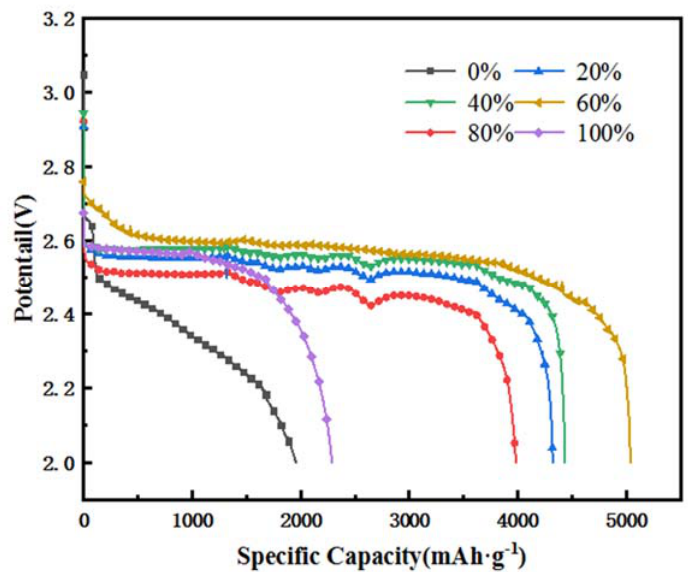
Figure 11. Discharge–charge profile of filling degree of electrolyte at the current density of 100 mA ∙ g − 1 with 2 V discharge and 4.5 V charge cutoff